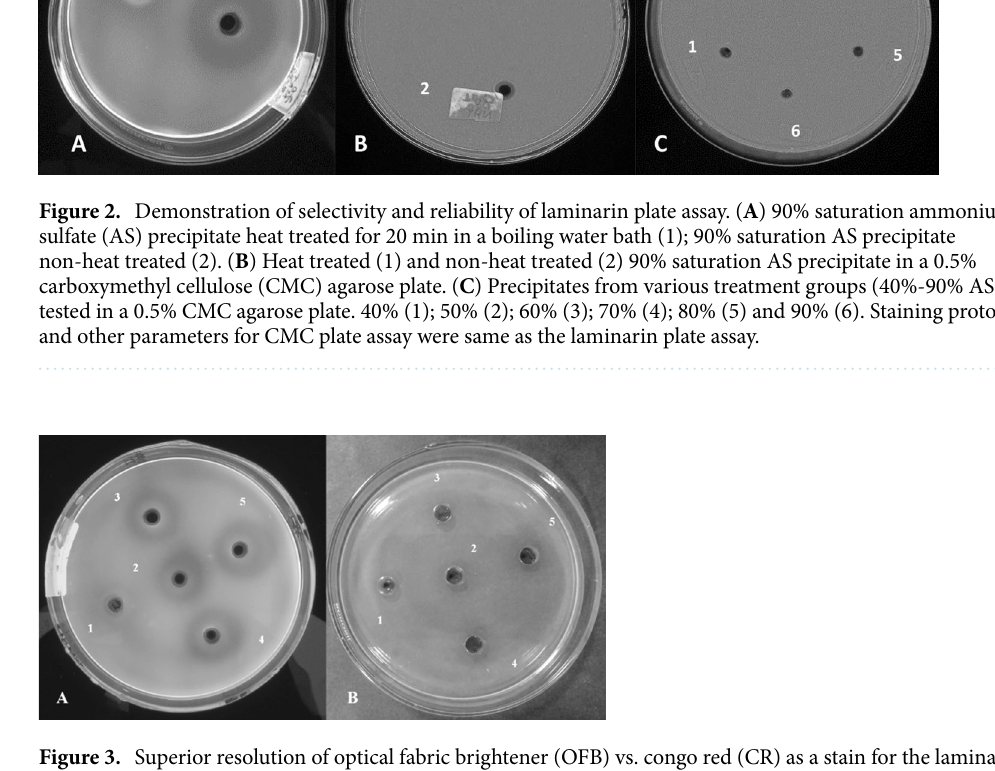
Figure 3. Superior resolution of optical fabric brightener (OFB) vs. congo red (CR) as a stain for the laminarin plate assay. Short Time Incubation (STI) samples (60%-90% AS treatment) were used as the enzyme source. ( A ) Plate stained with OFB and observed under UV light. Boiled sample 90% (1); 60% (2); 70% (3); 80% (4); and 90% (5). ( B ) Plate stained with CR and observed under white light. Boiled sample 90% (1); 60% (2); 70% (3); 80% (4); and 90% (5).